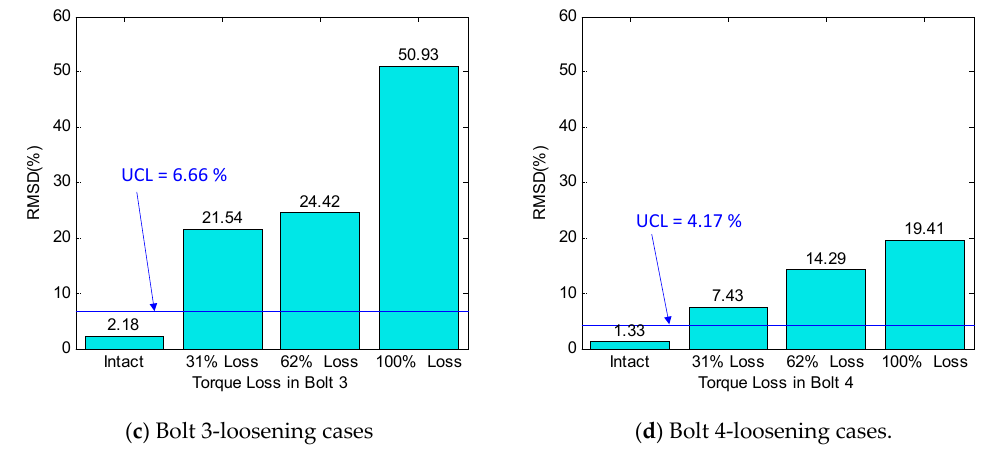
Figure 14. Preload change monitoring of bolted connection by root-mean-square deviation (RMSD) index.